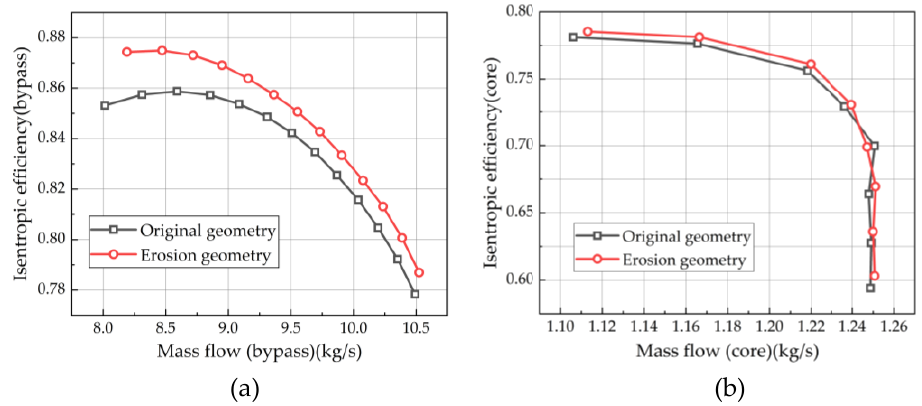
Figure 20. Characteristic line of the original and eroded blades with the change of back pressure at the ( a ) duct outlet and ( b ) core duct. Adapted from [85] of Shi’s group.